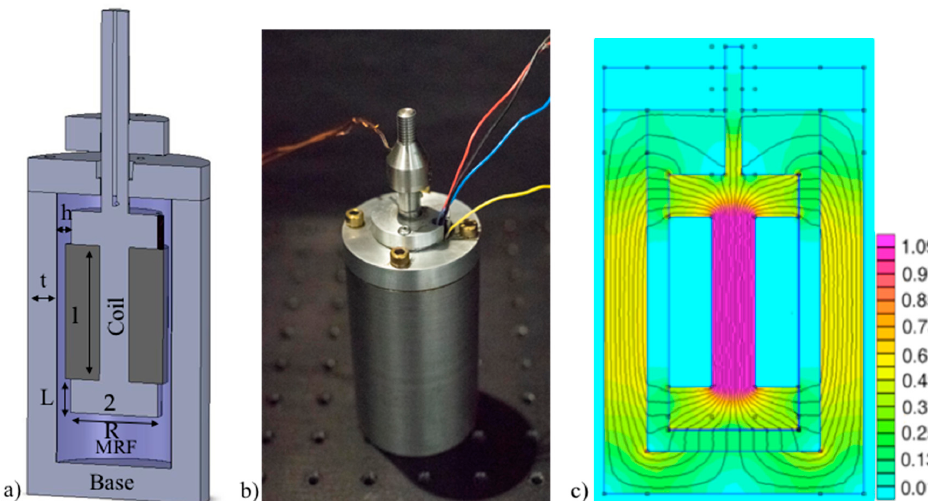
Figure 2. ( a ) The cross sectional view of MRF FGM, the MRF close to the coil, and within the base. The dimensions are as follows: l = 0.06 m, L = 0.01 m, t = 0.01 m, h = 0.005 m, R = 0.015 m, and r = 0.005 m. The coil is between the fluid and the base of the FGM. ( b ) Photograph of the MRF FGM. ( c ) Magnetic field distribution inside the MRF FGM that shows the magnitude of the flux density (T) within the MRF gap obtained with FEMM. The flux path is marked by contour lines, which form a loop through the structure.